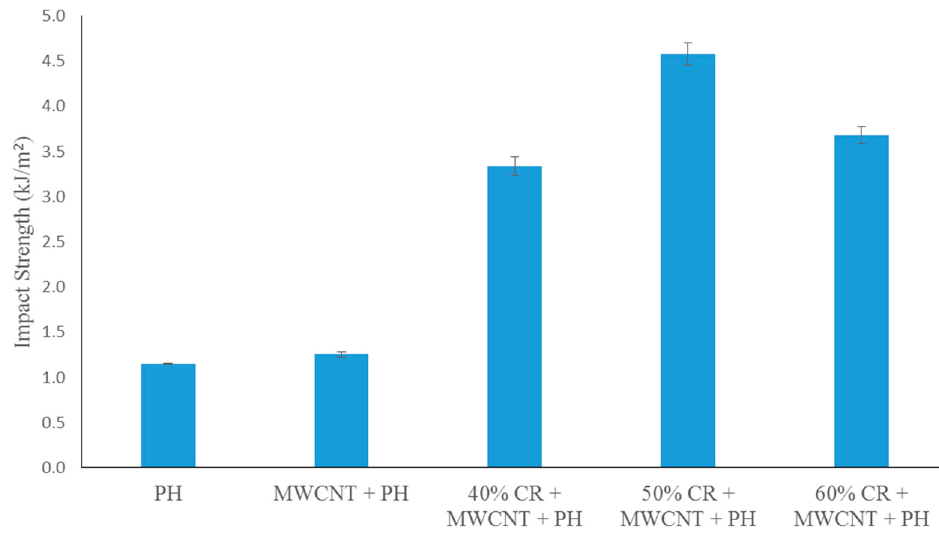
Figure 10. Effect of the fiber loading on impact strength of MWCNT-Phenolic composites .